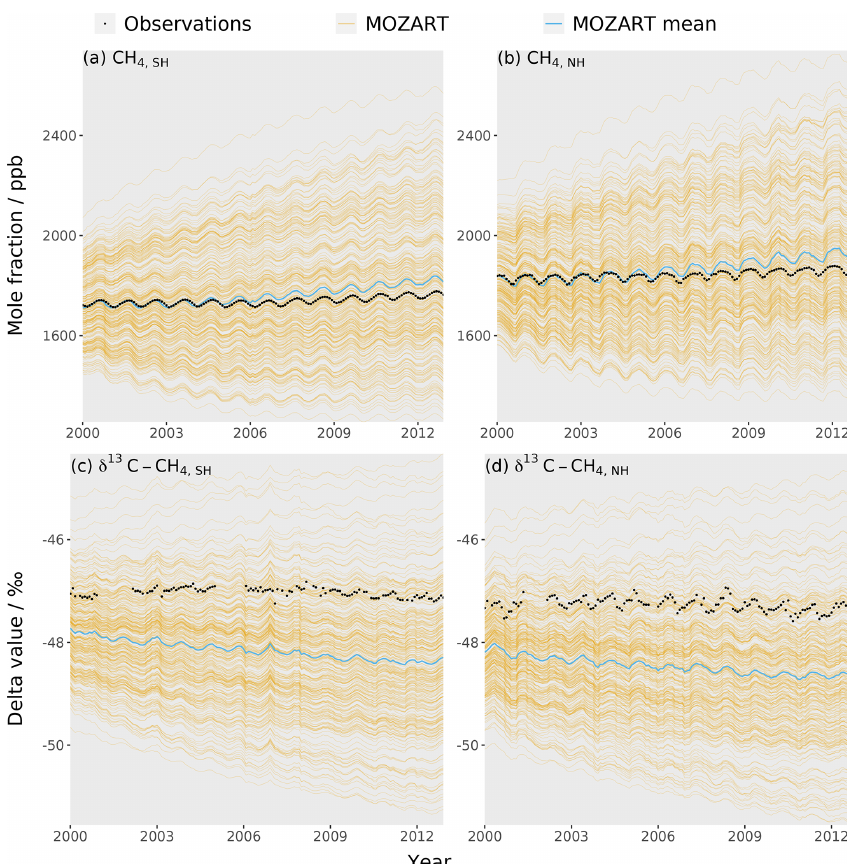
Figure 3. The MOZART training dataset (orange lines), the mean MOZART output (blue line), and the observations (black line) for each of the four emulators: (a) the Southern Hemisphere mole fraction, (b) the Northern Hemisphere mole fraction, (c) the Southern Hemisphere δ 13 C–CH 4 , and (d) the Northern Hemisphere δ 13 C–CH 4 . The observations are hemispheric averages based on NOAA and INSTAAR data (derived from a slightly different subset of measurement stations to those used in this work) presented in Rigby et al.